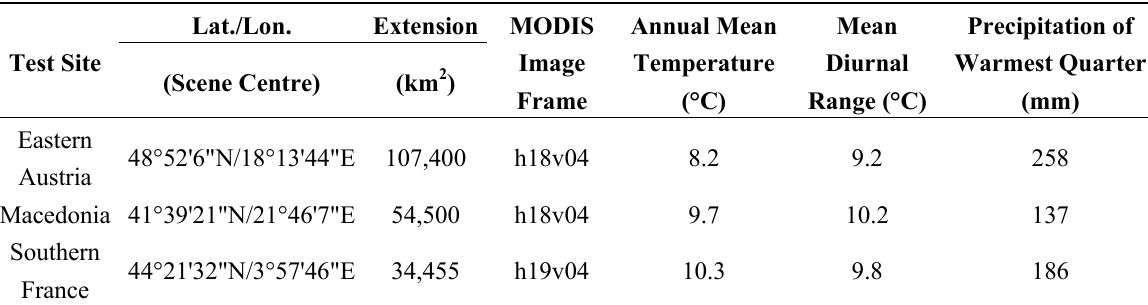
Table 2. Summary of the experimental test sites. The data used in this study consisted of 16-day Normalized Difference Vegetation Index (NDVI) composites for three test sites (2001 to 2010), from which averages and variances were calculated for each 16-day interval. Additionally, three climatic variables were used in the LC classification. Their respective average values are